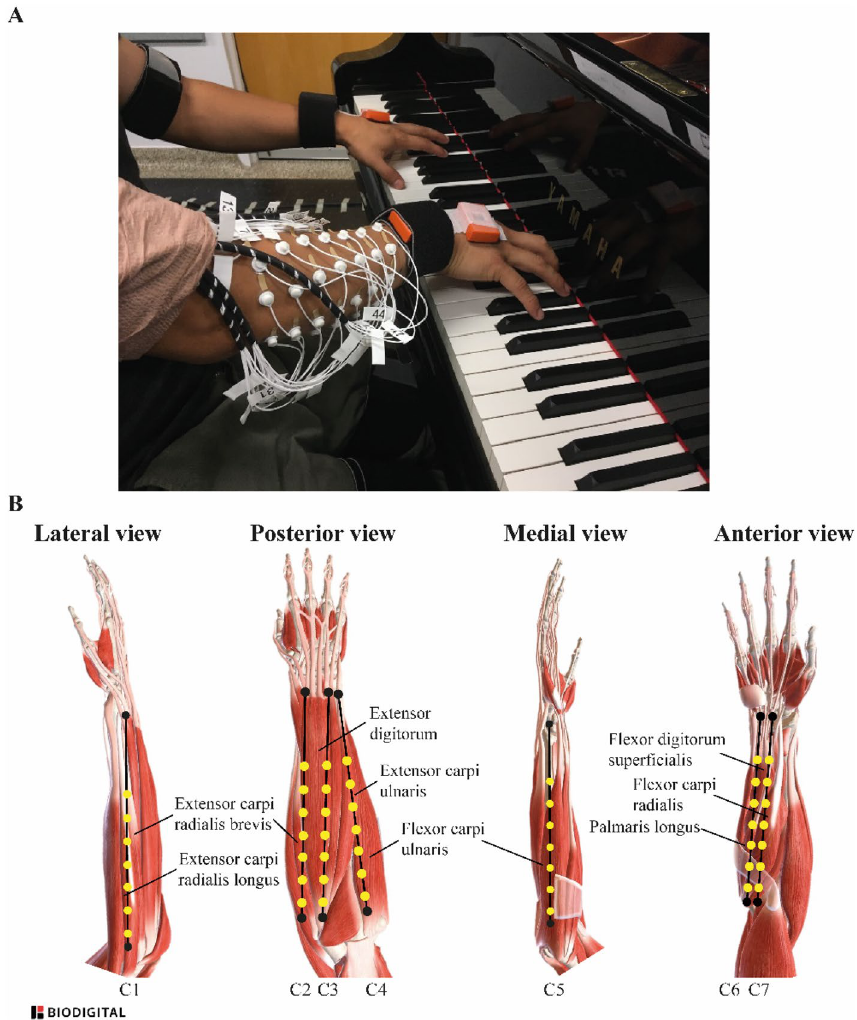
Figure 8. ( A ) close-up of the electrodes positioned on the forearm, and ( B ) schematic view of the 7 × 7 array of electrodes positioned on the forearm and the underlying muscles. Forearm views were generated through BioDigital and electrode positioning was drawn by the